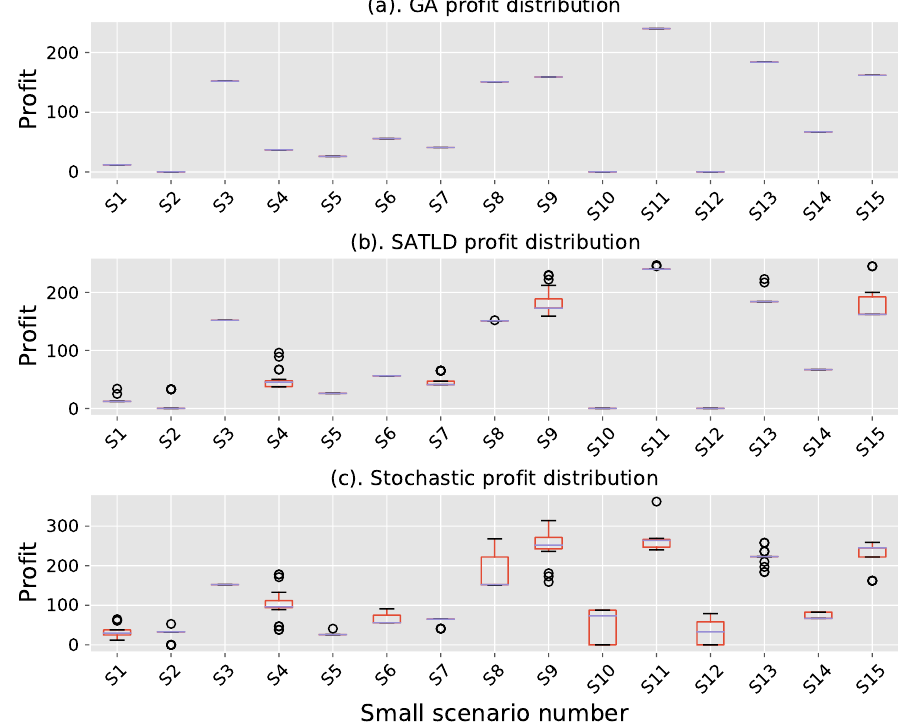
Figure 6. Distribution in small